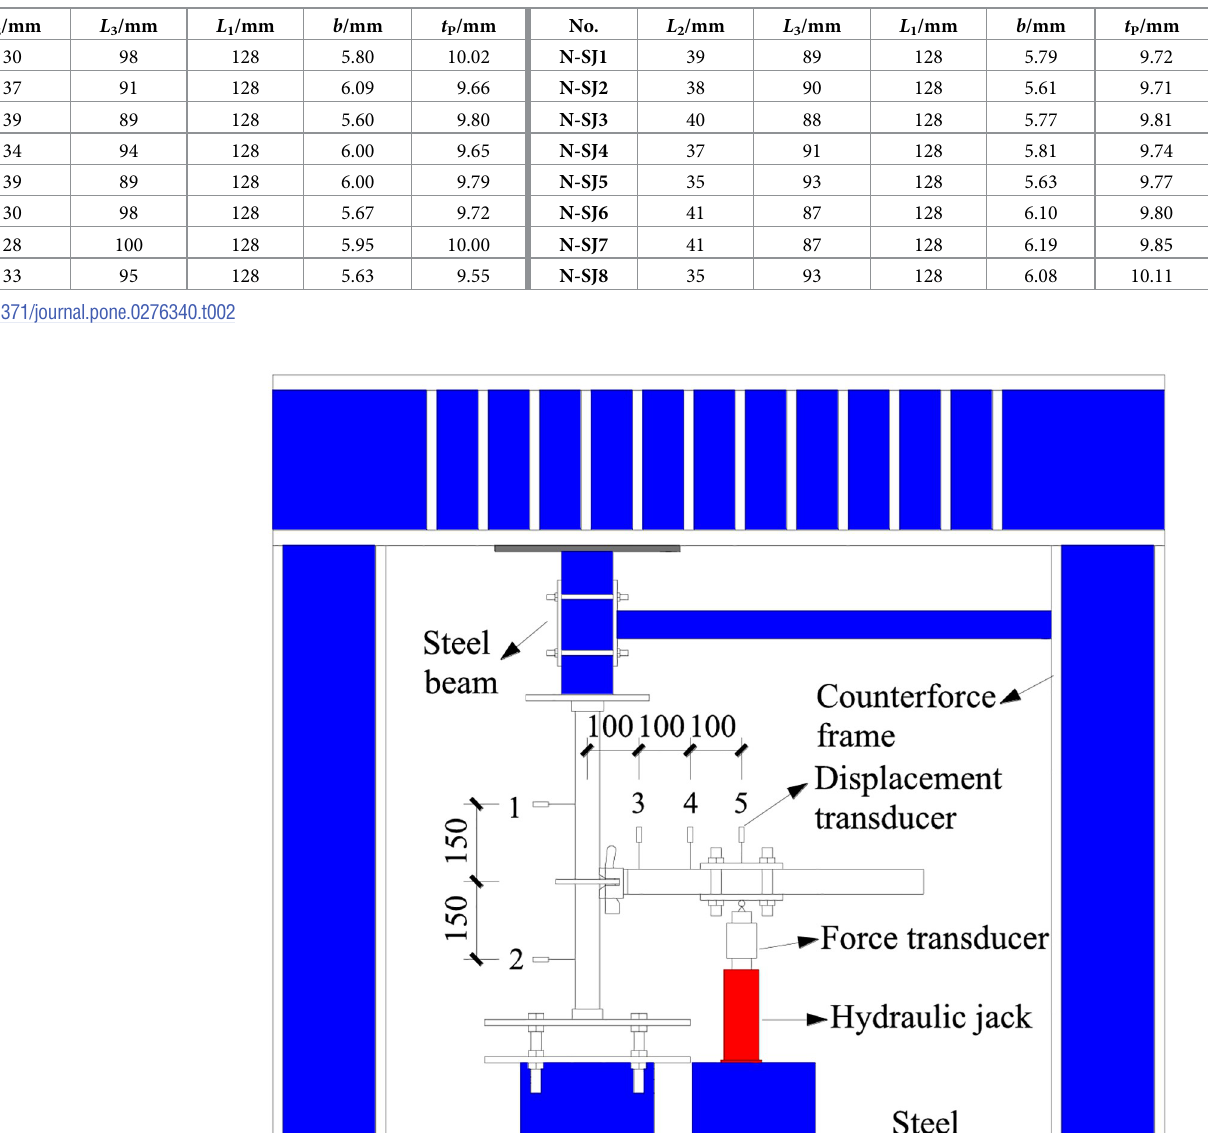
Table 2. Detailed dimensions of the insertion depth, thickness of the wedge and the disk-plate.